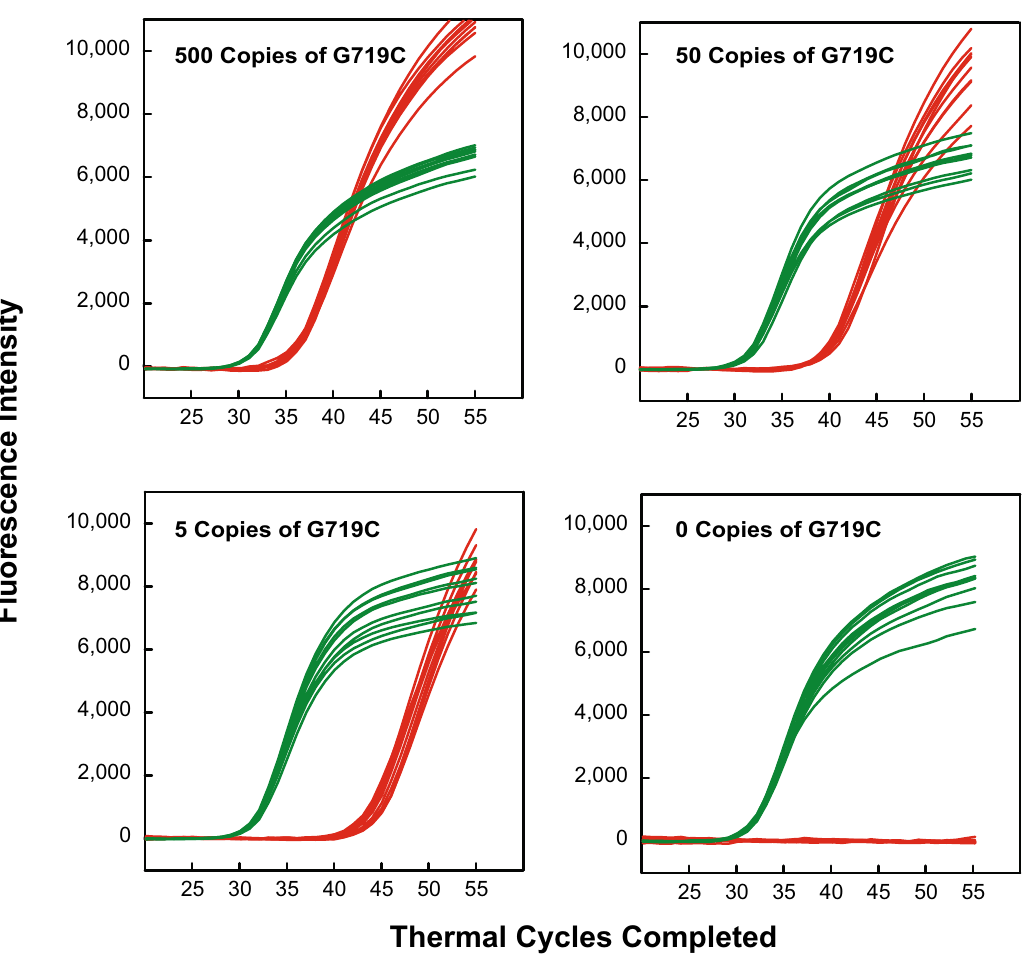
Figure 3. Demonstration of the sensitivity of PCR assays that utilize a pair of SuperSelective primers for the amplification of rare mutant DNA fragments in the presence of abundant DNA fragments from the entire human genome. Each reaction contained DNA fragments from 10,000 wild-type human genomes, including 10,000 copies of the β-actin reference gene (which reflects the amount of DNA in the sample). Four sets of ten identical PCR assays were carried out, each set containing either 500, 50, 5, or 0 copies of a linearized plasmid containing the EGFR G719C mutant DNA target sequence. Quasar 705-labeled molecular beacons lit up the amplicons generated from the β-actin reference gene (green curves), and fluorescein-labeled molecular beacons lit up the amplicons generated from the EGFR G719C mutant DNA target sequence (red curves). All ten reactions in which the sample contained only five mutant DNA target sequences produced a true-positive signal, while all ten reactions in which there were no EGFR G719C mutant DNA target sequences in the sample did not produce a signal above